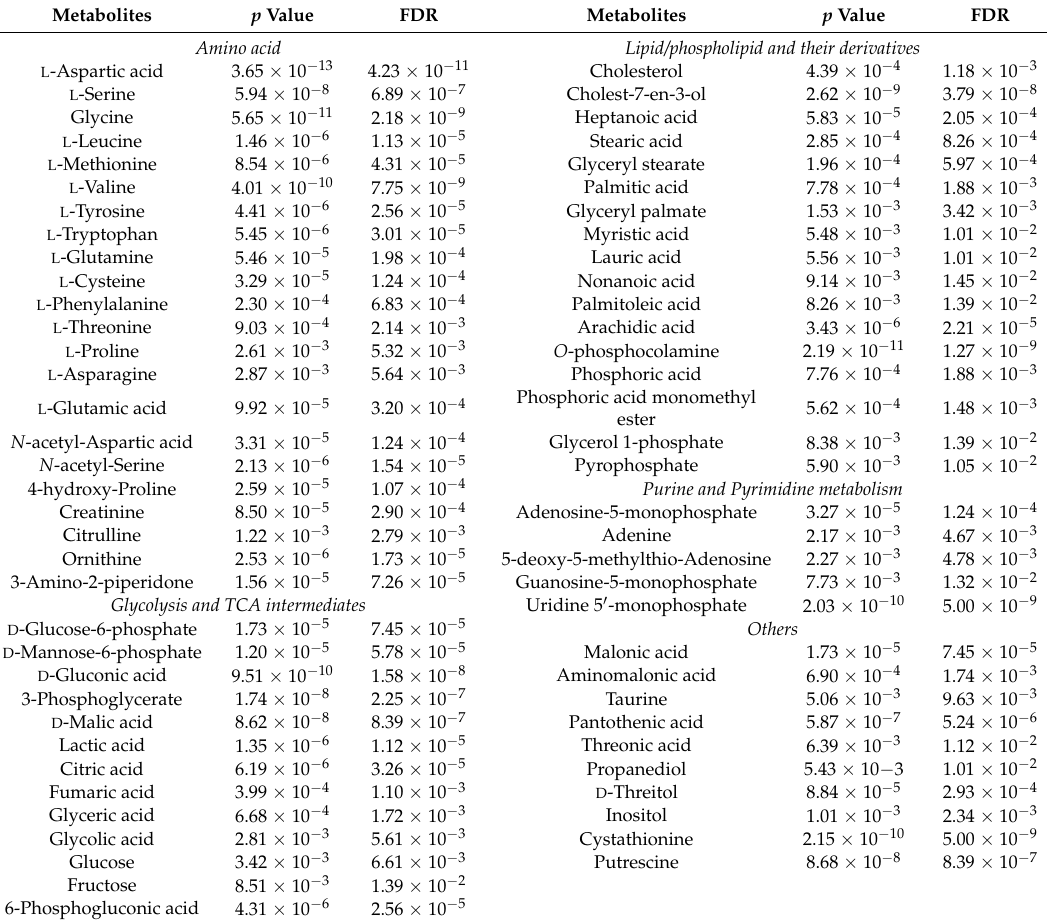
Table A2. Significant altered metabolites divided into different substance classes.